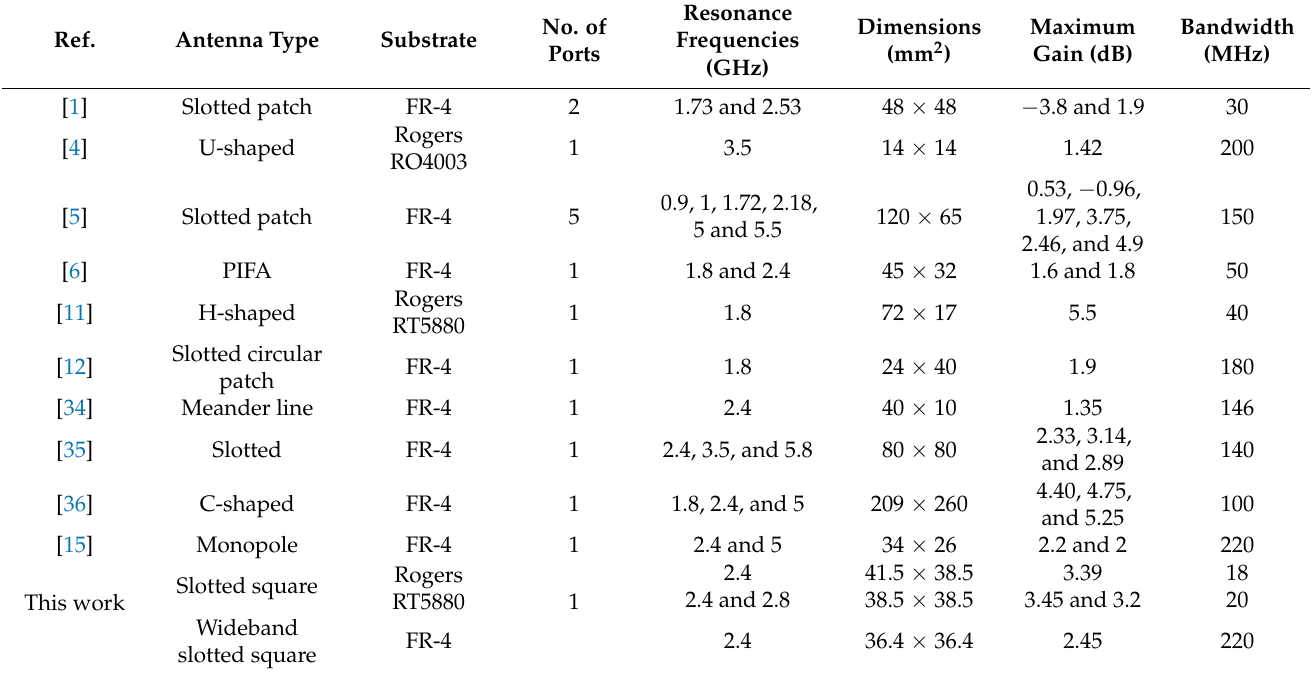
Table 1. Comparison of the proposed antenna with another state-of-the-art.